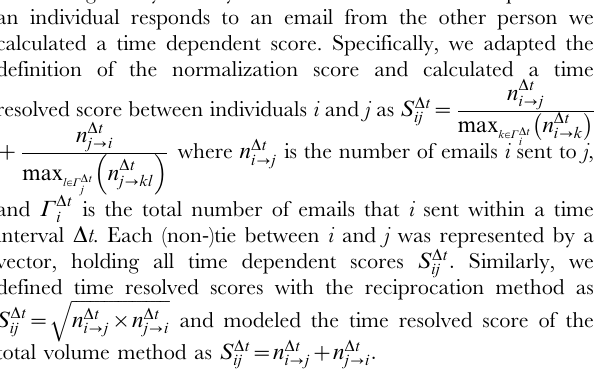
Figure S3 We display the frequency distribution of